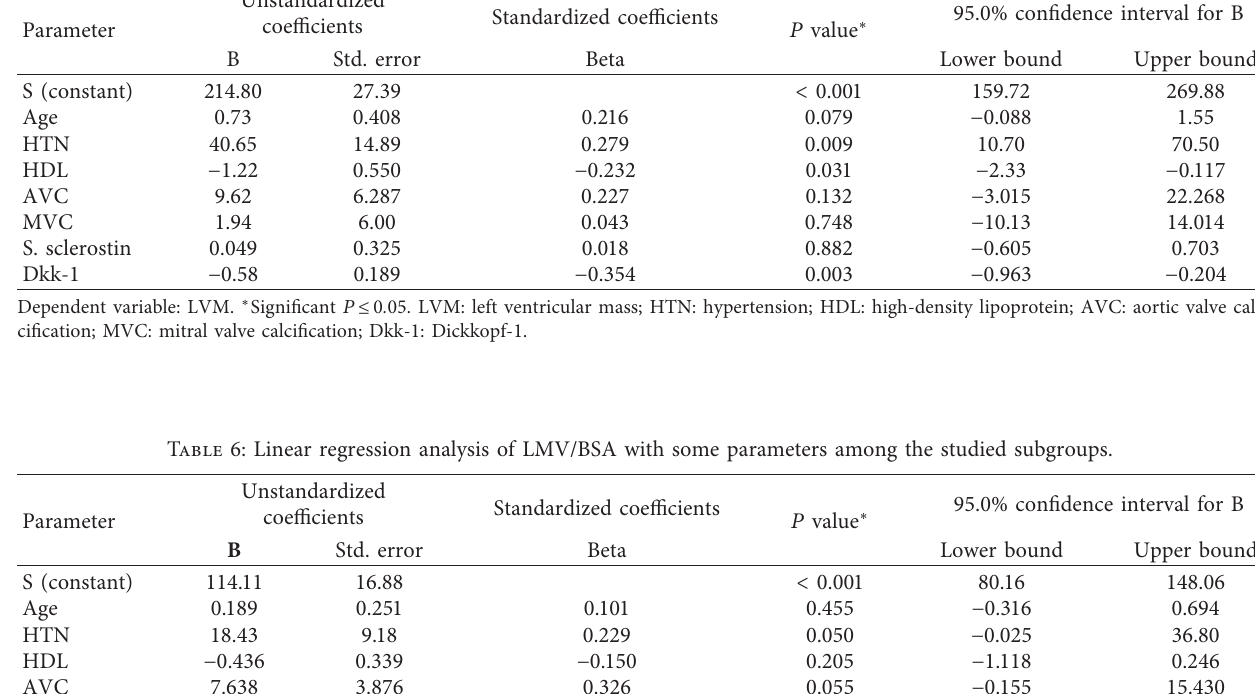
Table 5: Linear regression analysis of LMV with some parameters among the studied subgroups. Parameter